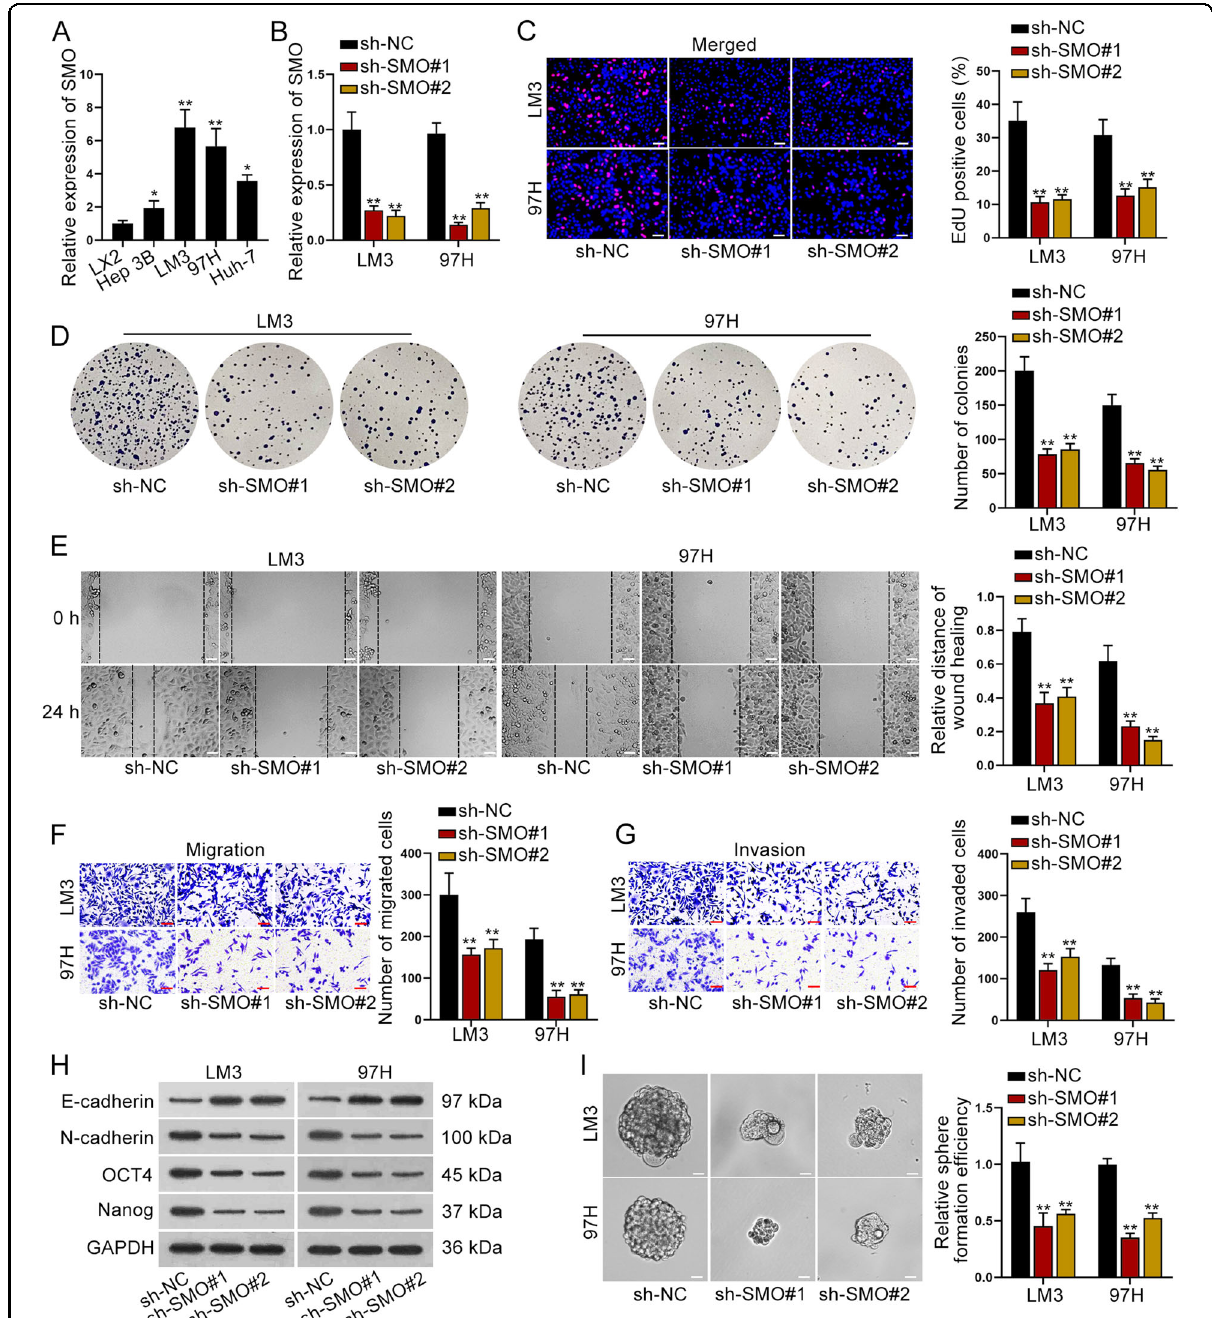
Fig. 1 SMO facilitated HCC cell proliferation, migration, invasion, EMT process, and stemness characteristic. A qRT-PCR revealed the expression level of SMO in HCC cell lines (Hep 3B, LM3, 97H, and Huh-7) and HSC cell line (LX2). B qRT-PCR veri fi ed the depletion ef fi ciency of SMO in LM3 and 97H cells. C – D EdU (bar value = 100 μ m) and colony formation assay revealed in the proliferation of HCC cells under the depletion of SMO or not. E Wound-healing assay showed the migration ability of HCC cells with or without downregulated SMO (bar value = 80 μ m). F – G Transwell assay revealed HCC cell migration and invasion ability in response to SMO silence (bar value = 50 μ m). H Western blot detected the expression of E- cadherin, N-cadherin, OCT4, and Nanog in HCC cells transfected with sh-NC or sh-SMO#1/2. I Sphere formation assay revealed the sphere formation ef fi ciency of HCC cells after silencing SMO (bar value = 50 μ m). * P < 0.05, ** P <